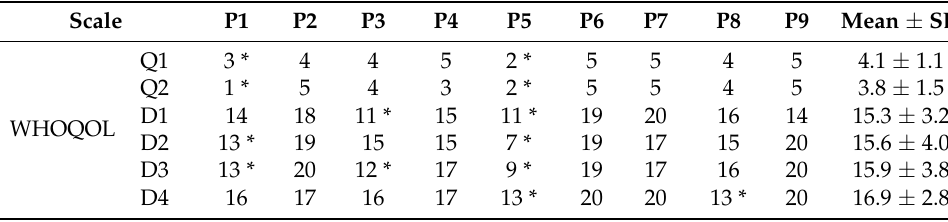
Table 3. WHOQoL-BREF scores (* lowest scale scores).